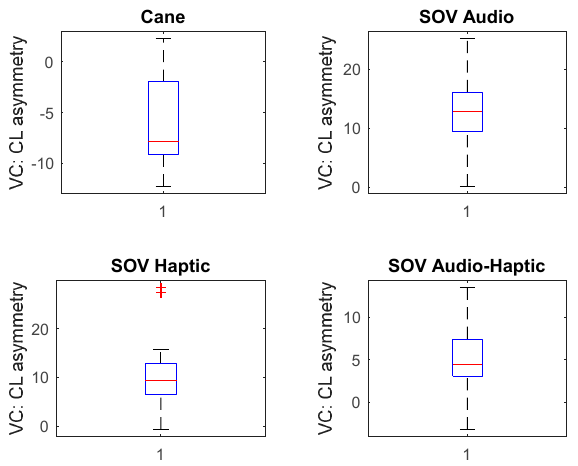
Figure 29. Visual cortex activity for UserB (late-blind).